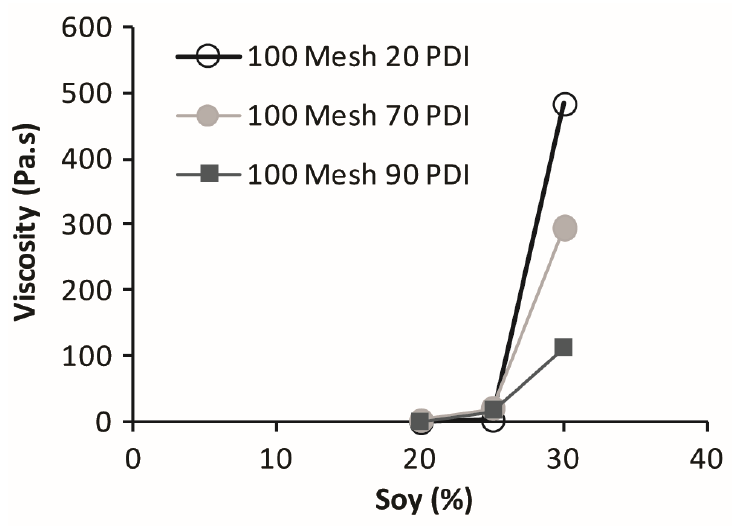
Figure 1. Effect of soy solids content and protein dispersibility index (PDI) on viscosity of adhesives made from 0.152mm (100 mesh) soy flour, data from [10].